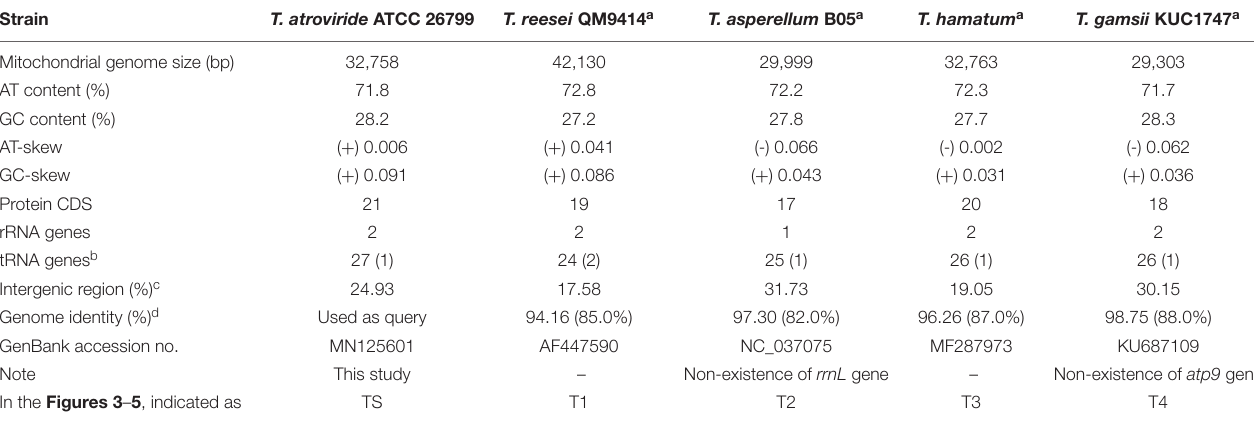
TABLE 2 | Features of Trichoderma mitochondrial genomes that used for comparative